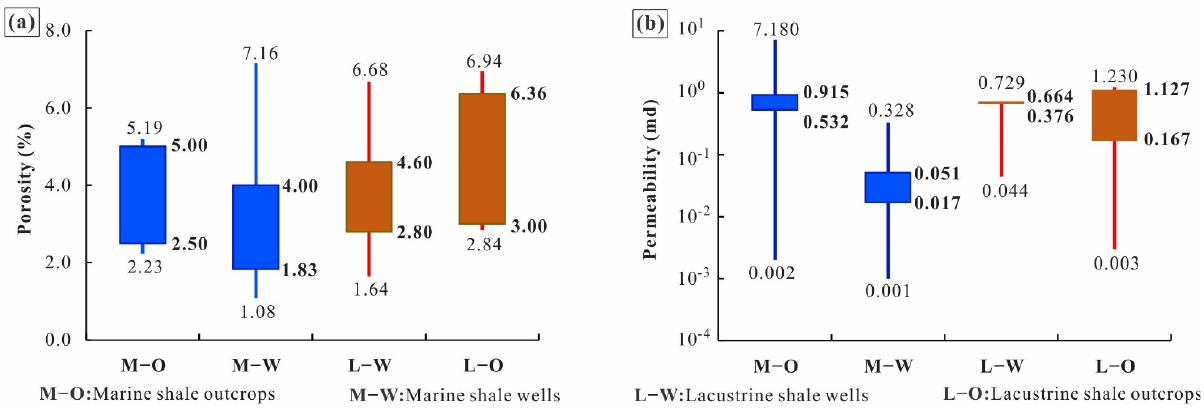
Figure 7. The reservoir physical properties of the marine and lacustrine shale samples. ( a ) The porosity tested results of the marine and lacustrine shale; ( b ) The permeability tested results of the marine and lacustrine shale